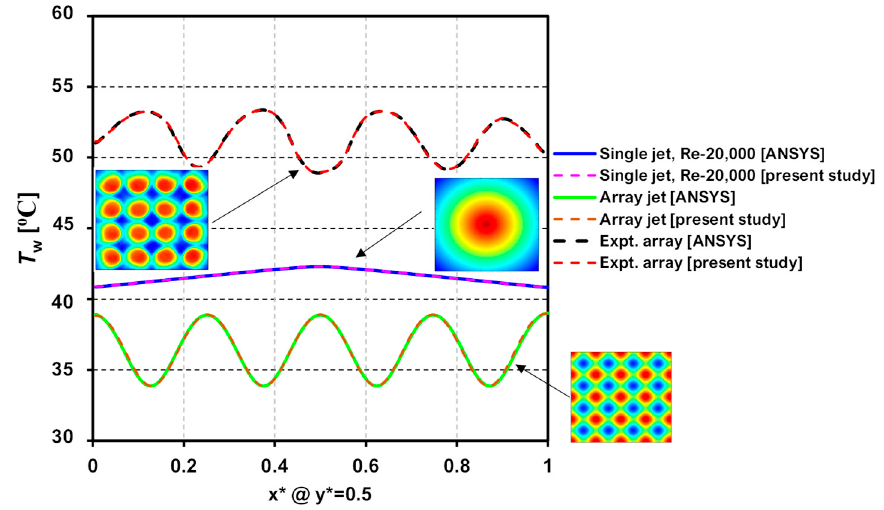
Figure 3. Comparison of surface temperature (at centerline) between in ‐ house code and FLUENT for all three cases. all three